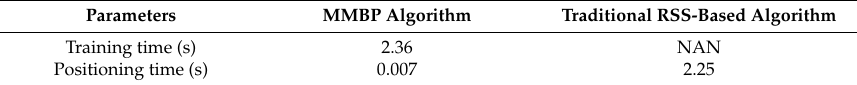
Figure 11. Arbitrary training data set. To verify the adaptability of the proposed algorithm, we also demonstrate the performance achieved using an arbitrary training set and the arbitrary training data set is shown in Figure 11. Unlike the neural network with the even training data set, best performance is obtained with 10 nodes in the hidden layer. The experimental results are shown in Figure 12.